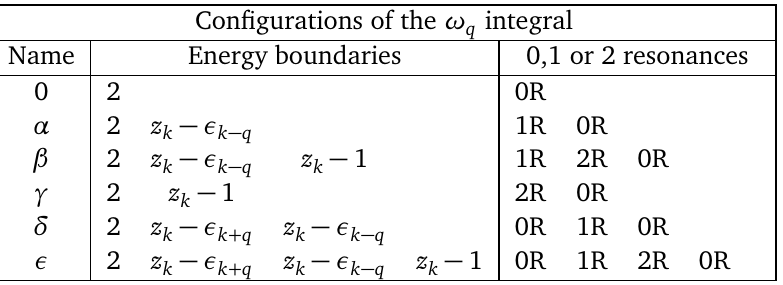
Table 1: Resonance configurations of the integral over ω but after integration over u ). The table reads as follows: the configuration β has 1 < z − ε resonance angle (1R) for 2 < ω , 2 angles (2R) for z q k k − q > z − 1. The configurations symbolized by the prime letters and 0 angle (0R) for ω q k α (cid:48) ,... ε (cid:48) are deduced from α ,... ε by changing the value of the continuum threshold: ( q > 2 k ) . The tilde configuration ˜ α , ˜ β , ˜ δ and ˜ ε are obtained by swapping 2 → ε c 0 ε and ε in the energy boundaries of α , β , δ , ε . k − q k + q